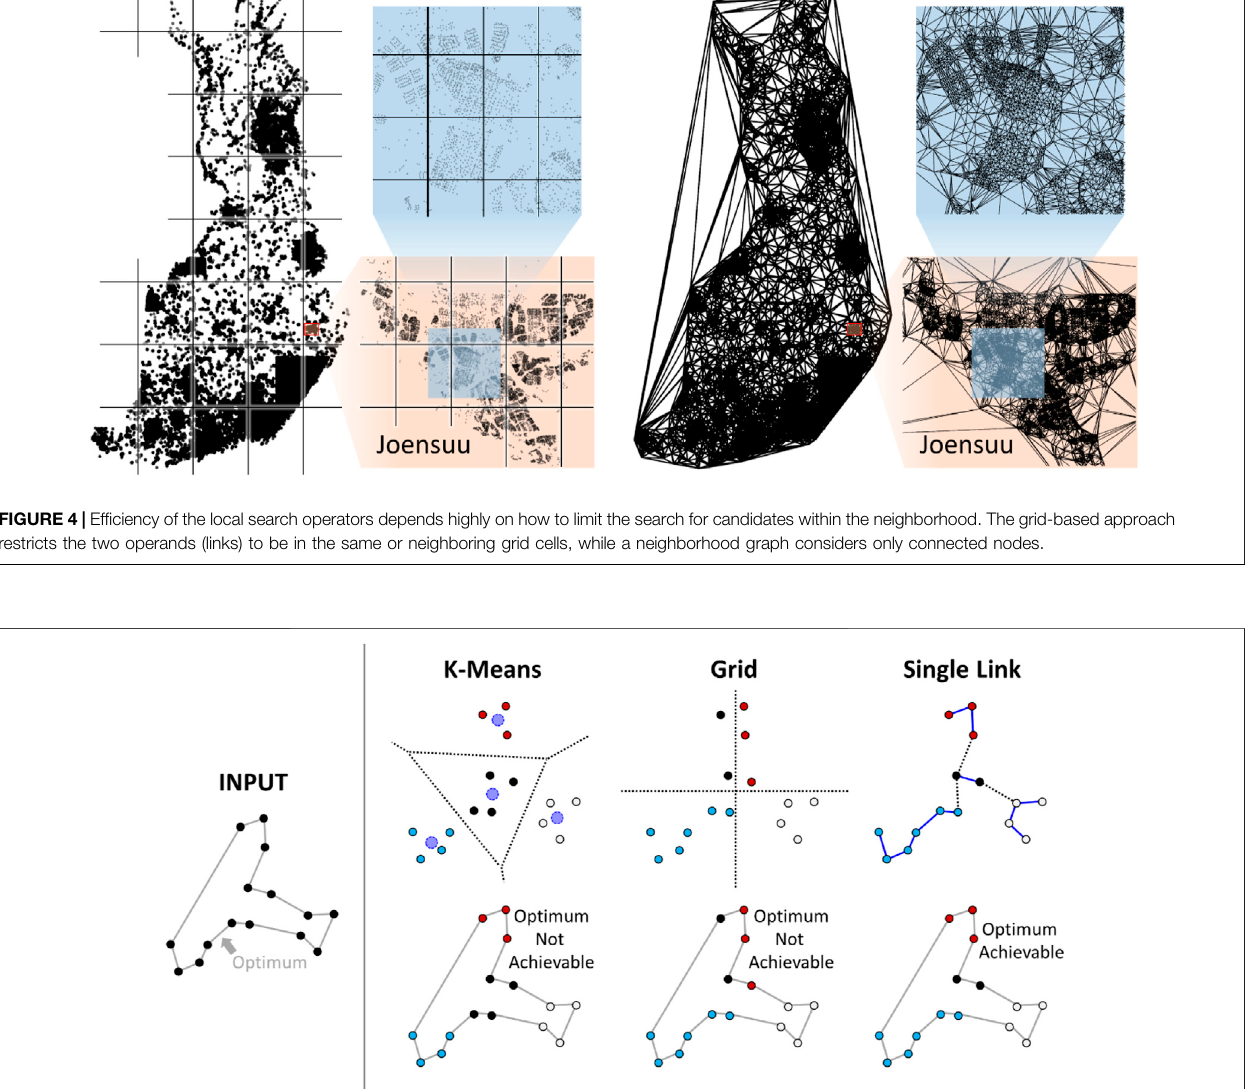
Frontiers in Robotics and AI |